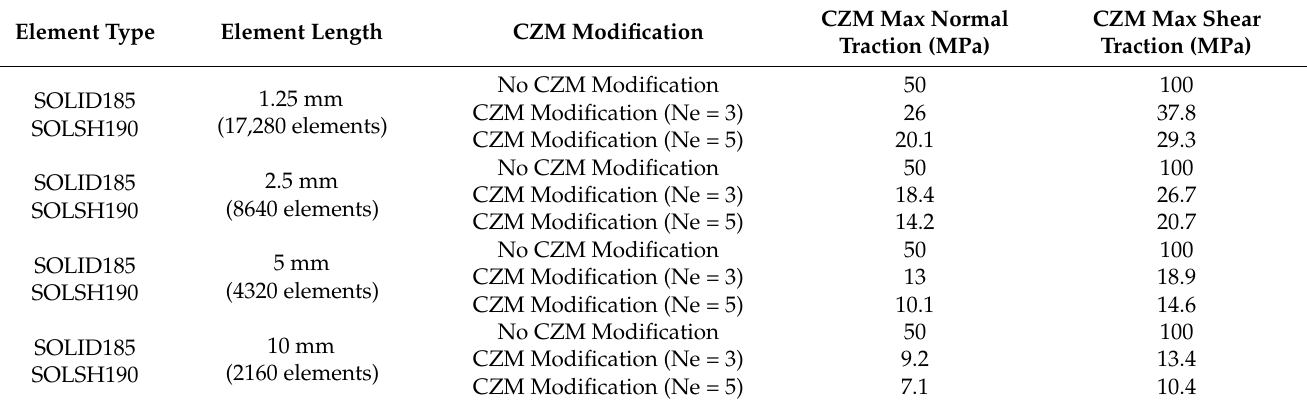
Table 2. Bilinear CZM